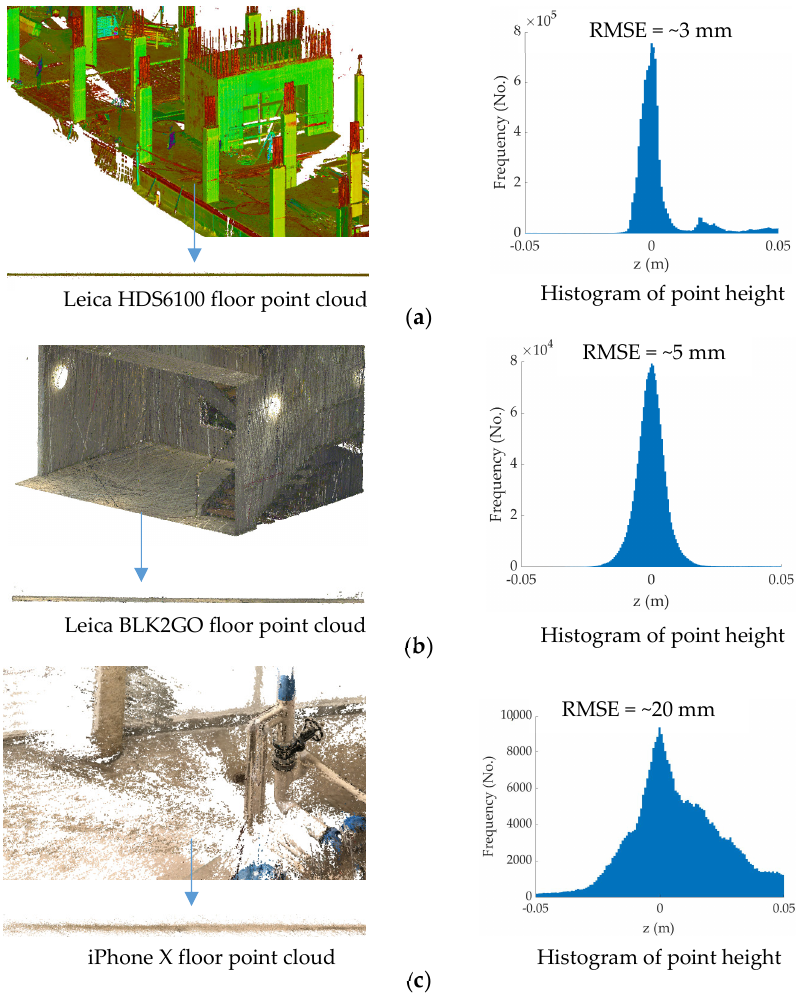
Figure 2. Sample point cloud (left) and histogram of point height (right) for ( a ) Leica HDS6100 terrestrial laser scanner (TLS) [43], ( b ) Leica BLK2GO mobile scanner [44], and ( c ) 3D reconstruction using iPhone X images.